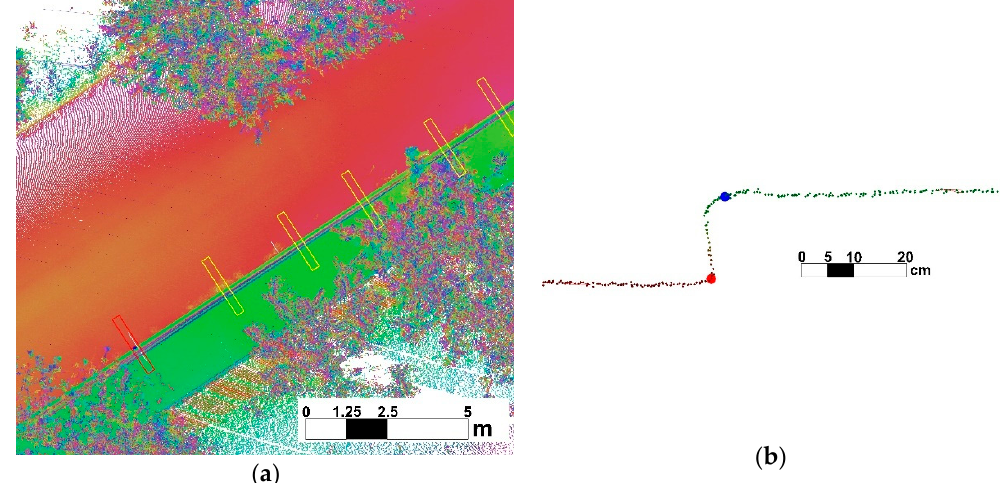
Figure 16. Manual break line extraction method: ( a ) sequential bandwidths footprint along the break lines and ( b ) profile view including the bottom and top points.